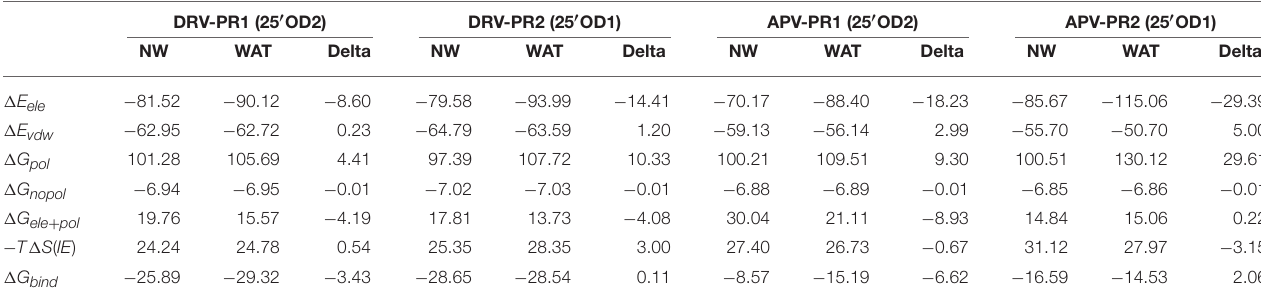
TABLE 4 | Comparison of binding free energy with bridging water (WAT) and no bridging water (NW) when using the PPC-IE method in the 25 ′ OD1 protonated